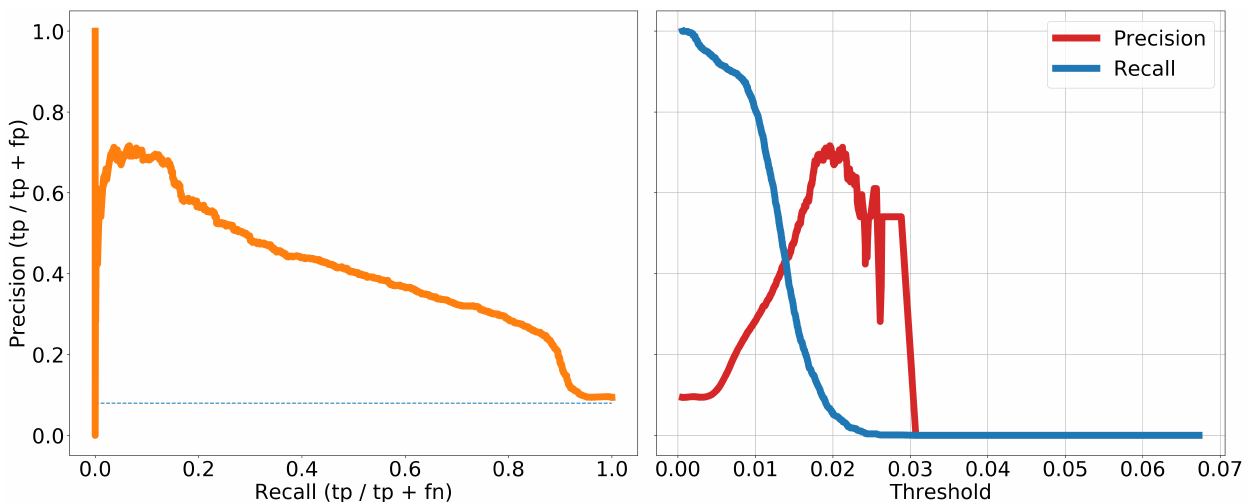
Figure 8. Precision-Recall curve for threshold